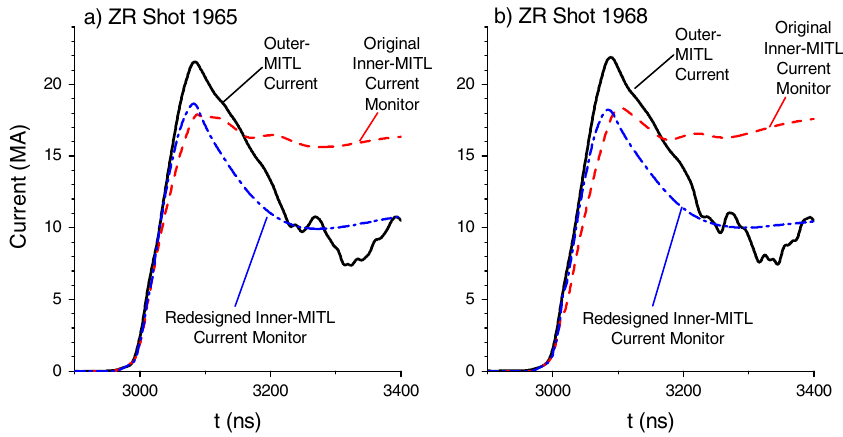
FIG. 9. (Color) Outer-MITL current (solid black line) and inner-MITL load-current measurements from two ZR shots with high- impedance imploding liner loads. The current obtained from the original inner-MITL monitor design is shown as a red dashed line and the current obtained from the redesigned inner-MITL monitor is shown as a blue dash-dotted line.